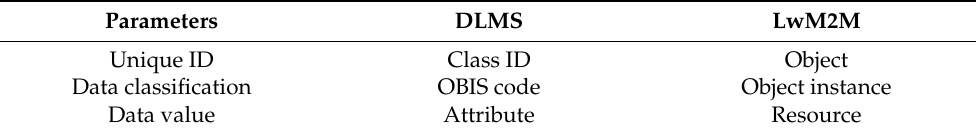
Table 4. Comparison of resource management features between DLMS and LwM2M protocols.